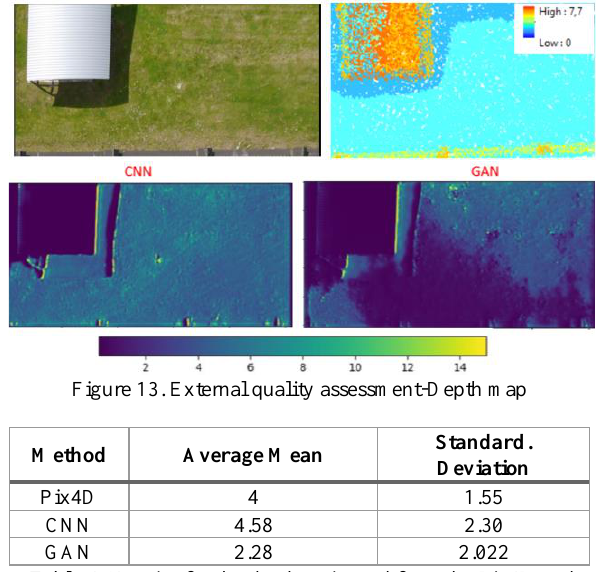
Table 4. Metrics for the depth estimated from the Pix4D and two models (in